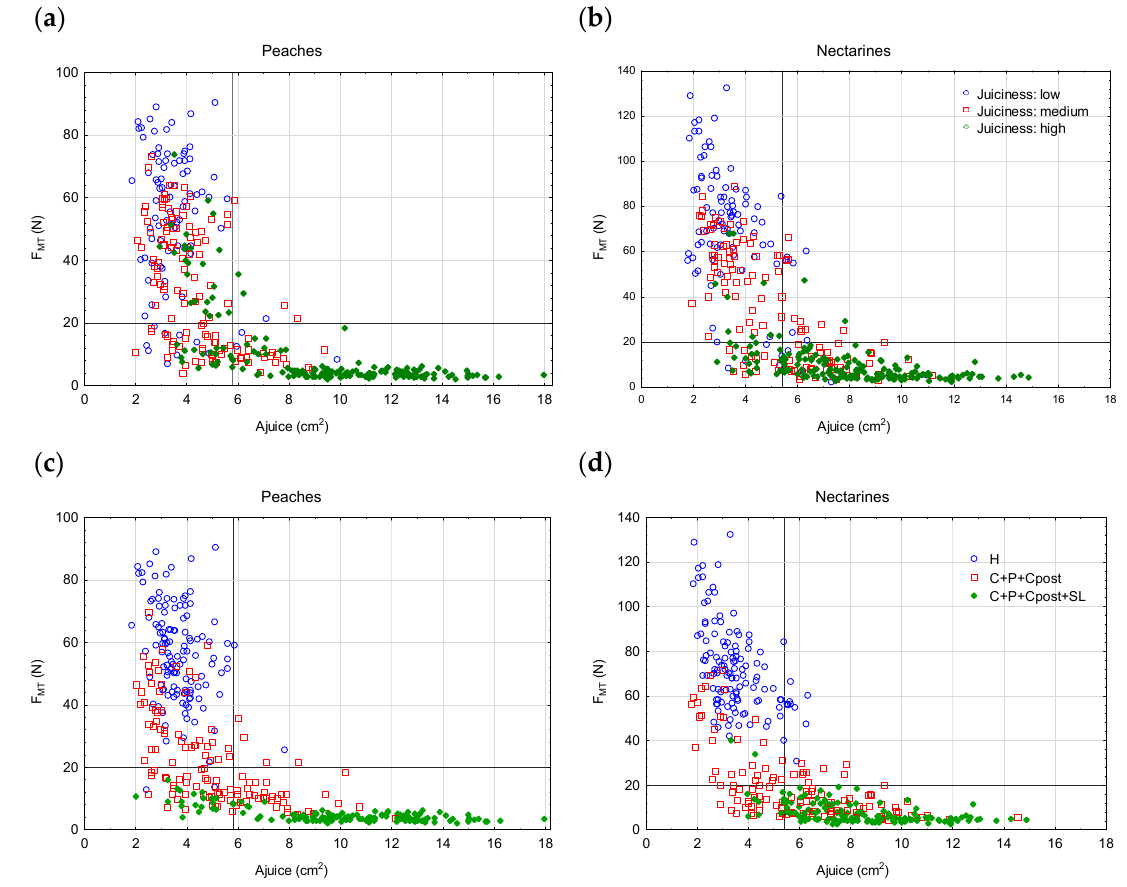
Figure 3. Scatterplot of the instrumental juiciness of the fruits of the 2019 season according to instrumental firmness, categorized by the class of sensory juiciness in ( a ) peaches and ( b ) nectarines, and categorized according the postharvest protocol for ( c ) peaches and ( d ) nectarines. The black lines indicate the limits of firmness and instrumental juiciness (10th percentile) that delimit soft and juicy fruits.